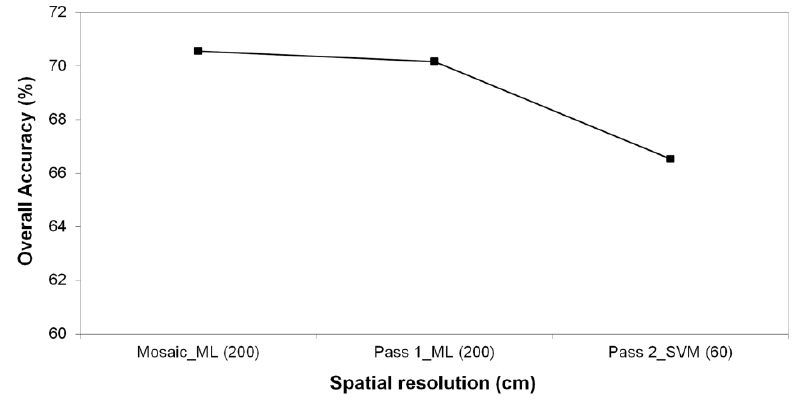
Figure 4. Comparison between images based on the highest